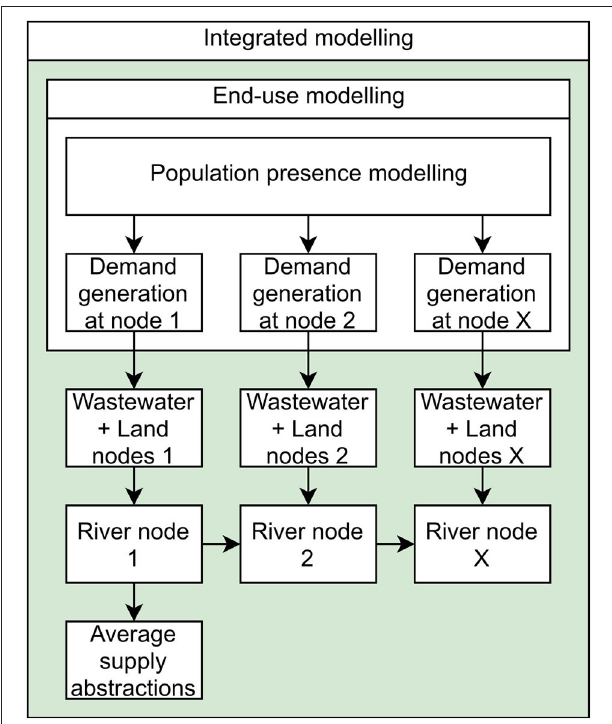
FIGURE 2 | A generic illustration of the modelling domain for this